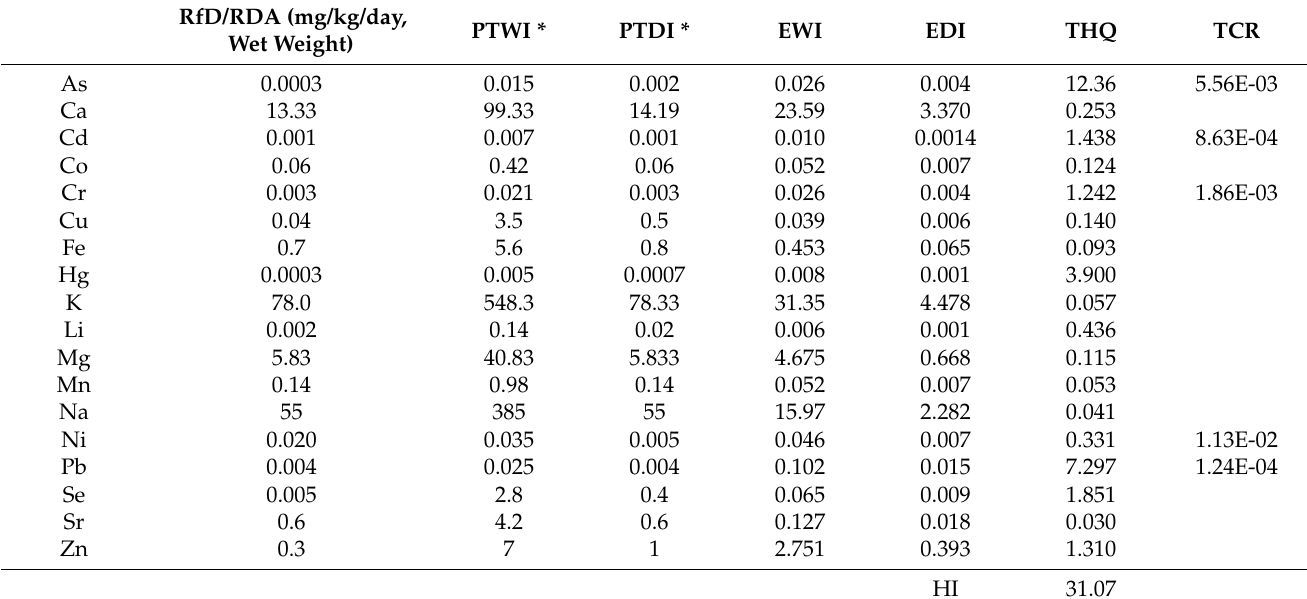
Table 5. Description of health risk assessment for selected metals in the muscles of Catla catla from Mangle